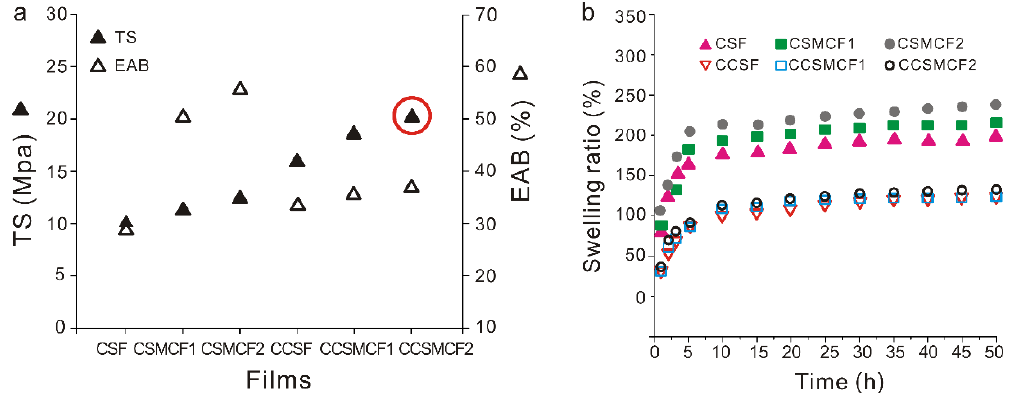
Figure 4. ( a ) The mechanical properties of the prepared films; ( b ) the swelling ratio of the obtained